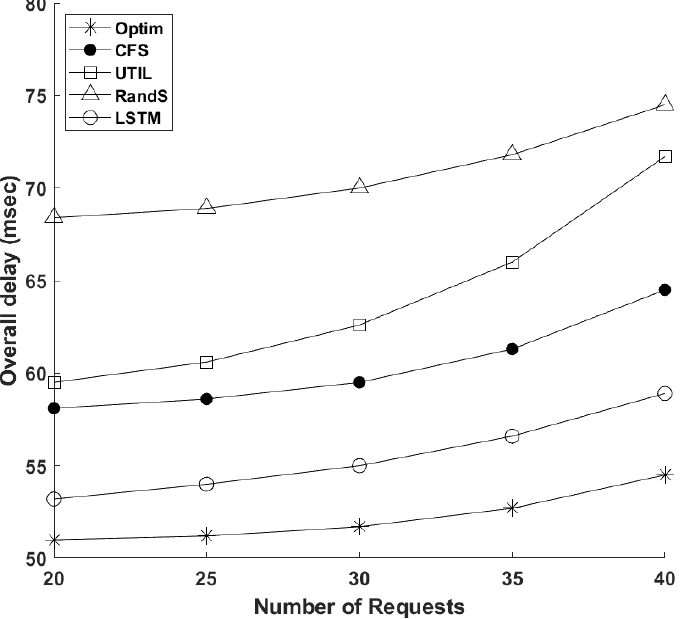
Figure 8. Service Delay with Different Number of Requests (6 EC, µ = 0.5, EC Capacity is 14 and Total Moving Probability is 1). CFS [34]; UTIL [35].